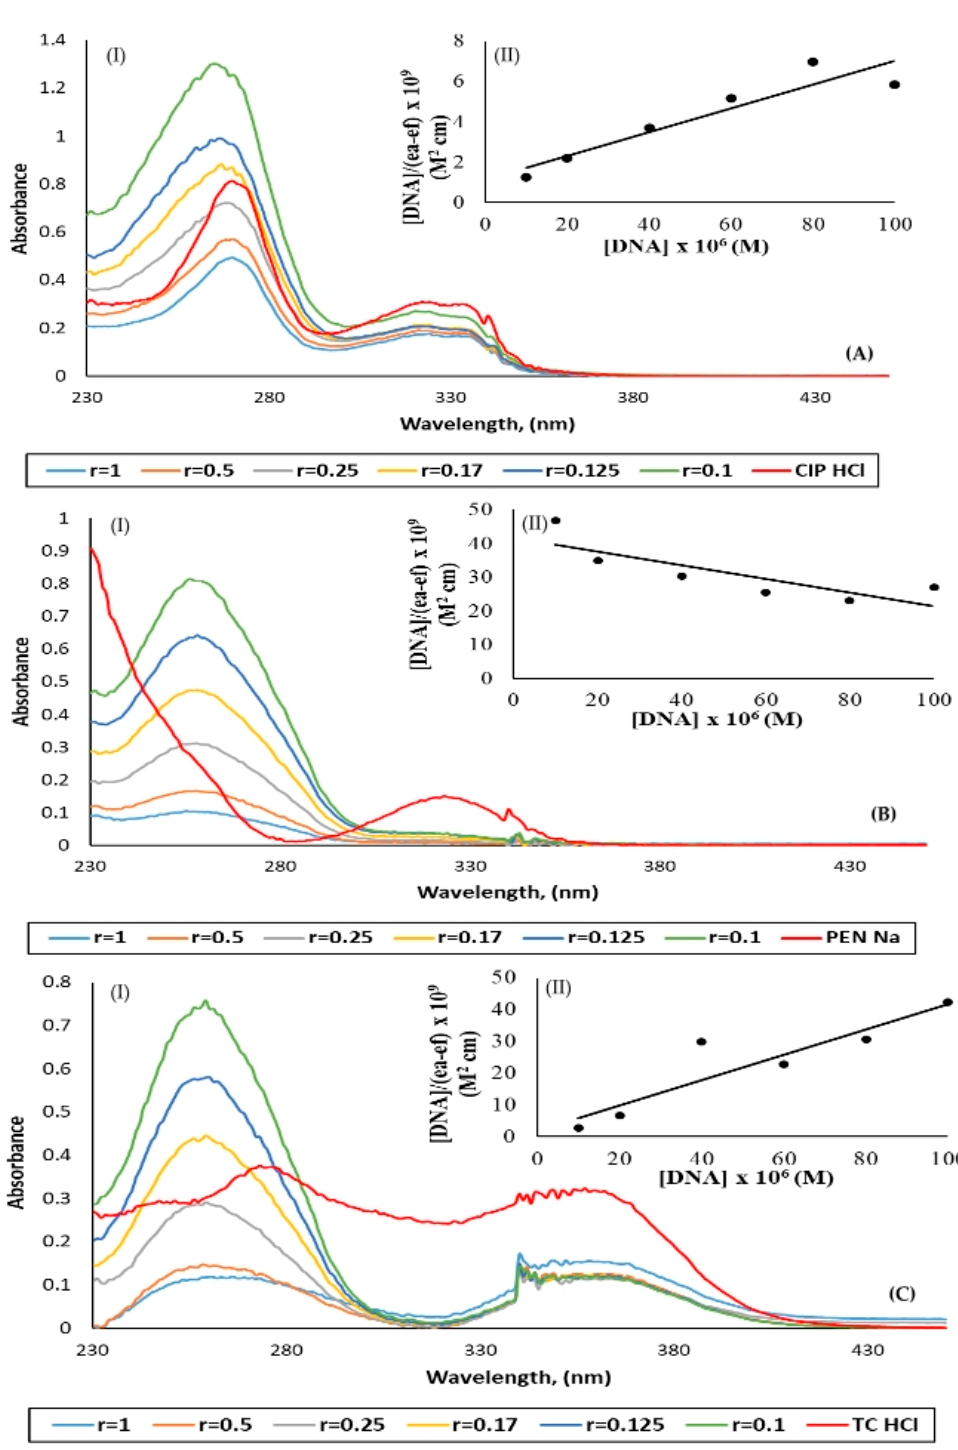
Figure 2. (I) UV spectra of complexes CIP · HCl ( A ), PEN · Na ( B ), and TC · HCl ( C ) in the absence and presence of CT-DNA at r values of 1, 0.5, 0.25, 0.17, 0.125, and 0.1 (r = [compound]/[DNA], [compound] = 10 µ M, [CT-DNA] = 10–100 µ M). (II) Graphical plot of [DNA]/(e a − e f ) vs. [DNA]. The CT-DNA solution, at a concentration of 10 mM, is incubated with the increasing amounts of antibiotics so that the molecular ratio [compound]/[DNA] reaches r = 0.37 in cases of CIP·HCl , TC·HCl , and r = 0.35 in case of PEN·Na . Figure 3 shows the relative specific viscosity ( n/n 0 ) 1/3 versus the [compound]/[DNA] ratio. The trend of lowering in the DNA solution viscosity with the increasing concentrations of the antibiotics CIP·HCl